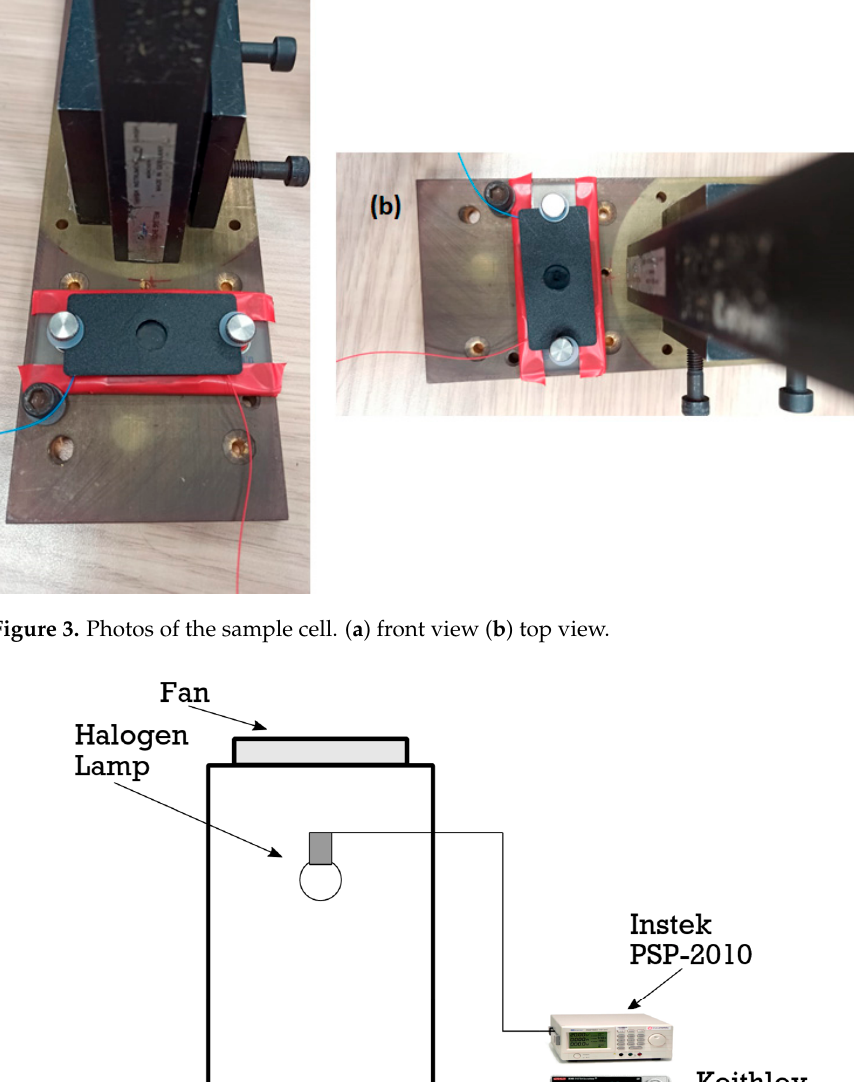
Figure 4. Experimental setup.